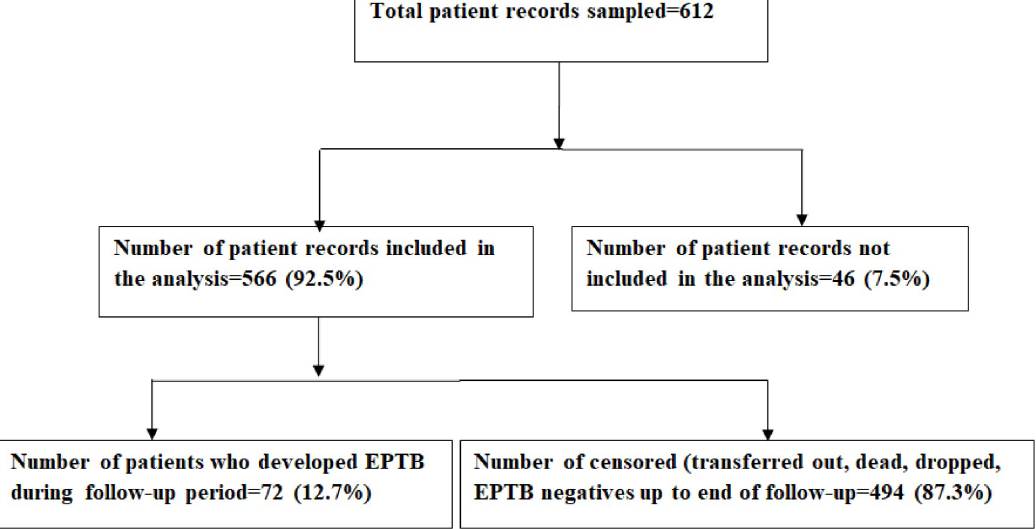
Fig 1. Flow chart, followed to assess the incidence of EPTB among HIV positive patients in Addis Ababa, Ethiopia, from 01 January 2013 up to 31 December 2018 (n = 612).